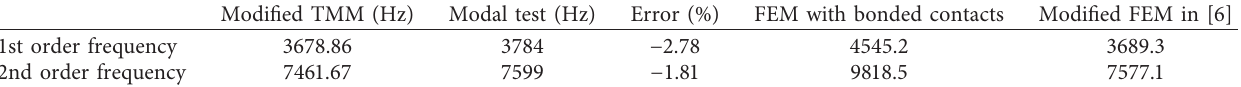
Table 5: The first two frequencies obtained by the modified TMM, modal test, and